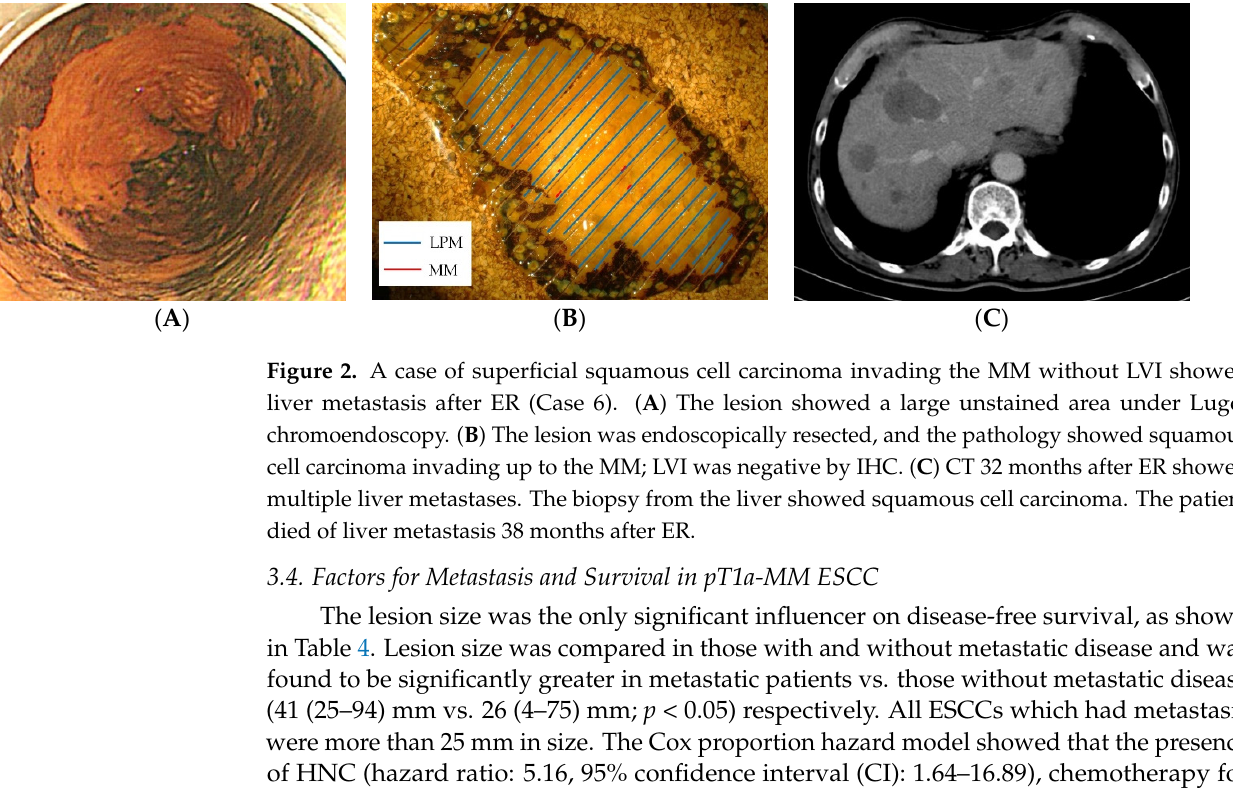
of liver metastasis 38 months after ER.